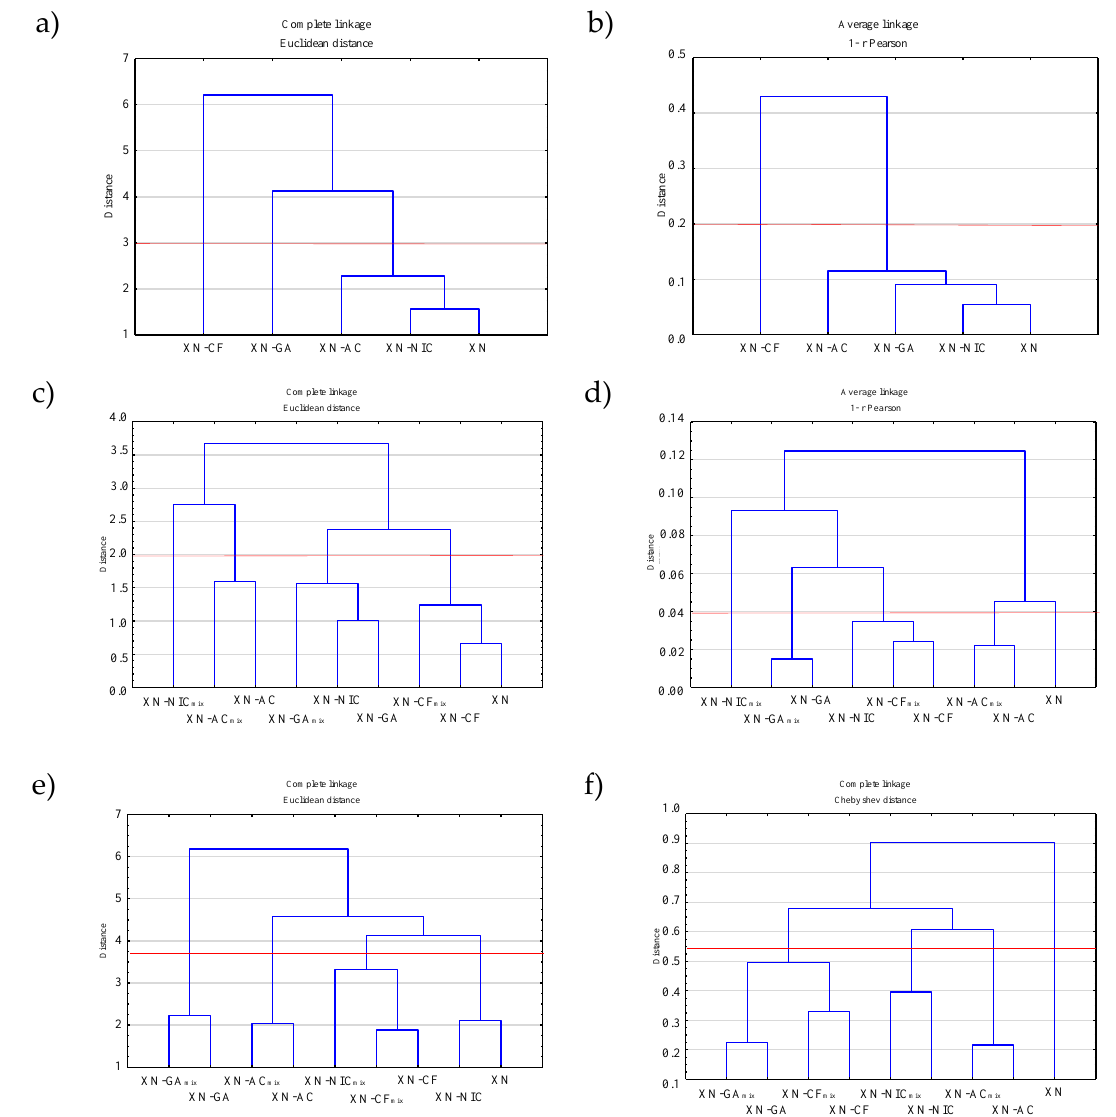
Figure 15. Hierarchical clustering analysis (HCA) tree diagrams for the data obtained from the ( a , b ) Raman, and ( c , d ) FTIR spectra in the regions of 3700–2700 cm − 1 and ( e , f ) 1800–1000 cm − 1 .